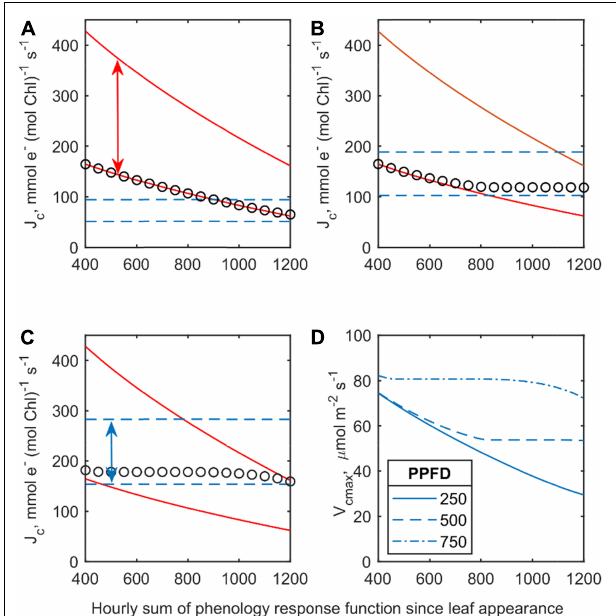
FIGURE 7 | (A–C) Simulated adaptation ranges of electron flow (lines) and final mean leaf rate (symbols) over time at different time constant PPFD: (A) 250 µ mol m − 2 s − 1 , (B) 500 µ mol m − 2 s − 1 , and (C) 750 µ mol m − 2 s − 1 . Lower and upper red lines are J x , max , mn and J x , max , mx , respectively. Lower and upper blue dashed lines are minima and maxima set by the profile of absorbed light, respectively. (D) Corresponding calculated rates of V cmax over